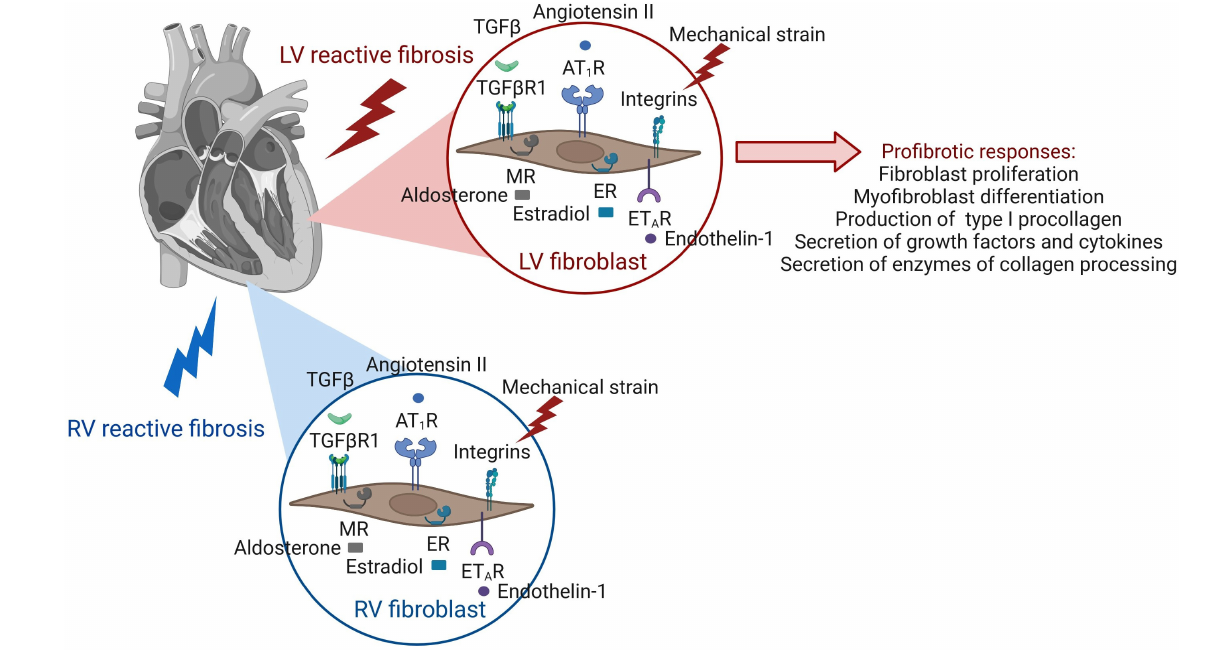
FIGURE 3 | Receptor activation of cardiac fibroblasts leads to pro-fibrotic cellular behaviors. The same receptors of fibroblast activation are present in the fibroblasts of both ventricles, but involvement of signaling pathways and functional outcome of fibroblast responses have been mostly studied in the